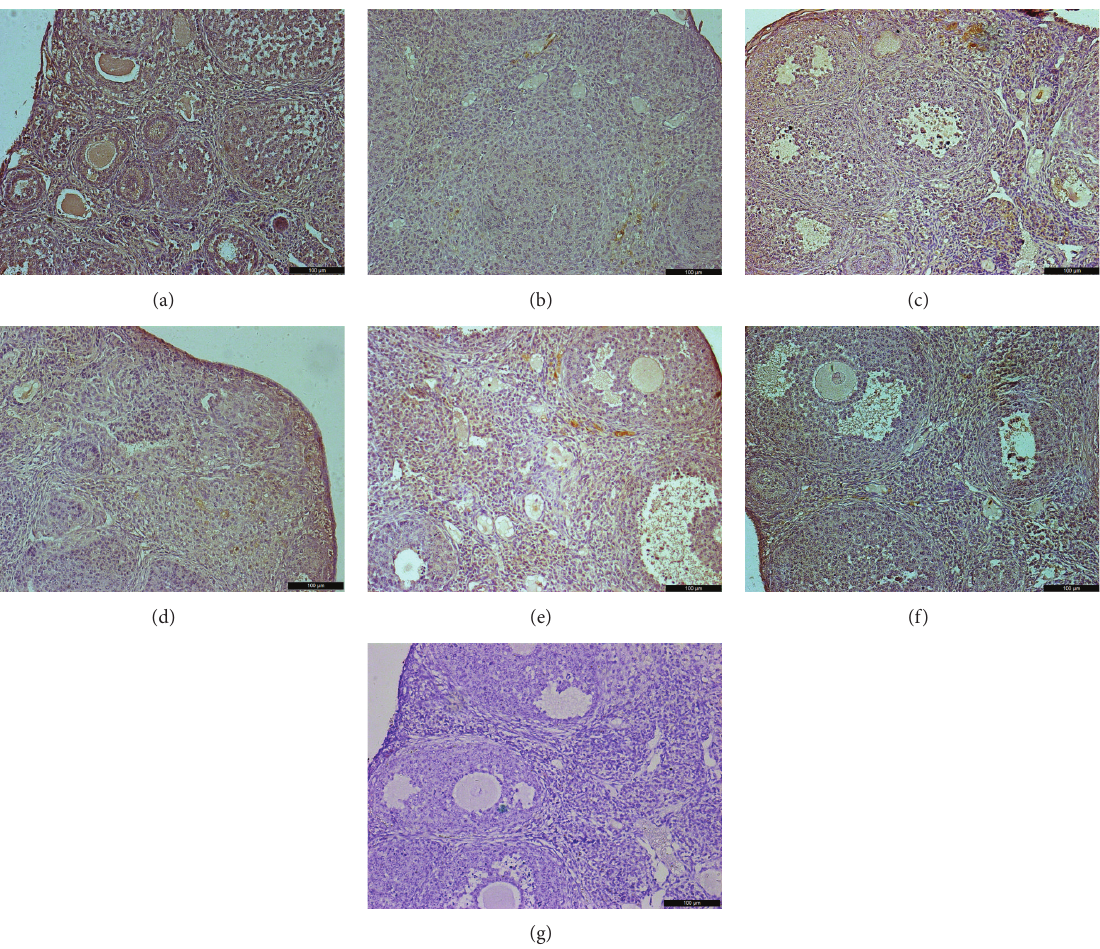
Figure 7: Immunohistochemical analysis for VEGFR2 expression in mice ovaries of different groups 2 weeks after treatment; ovarian sections withnoprimaryantibodywereservedasnegativecontrols.(a)controlgroup;(b)Bu/Cyadministratedgroup;(c)Bu/Cy+hAECs(24h)group; (d) Bu/Cy + hAECs-CM (24h) group; (e) Bu/Cy + hAECs (7d) group; (f) Bu/Cy + hAECs-CM (7 d) group; (g) negative control. Scale bar: 100 𝜇